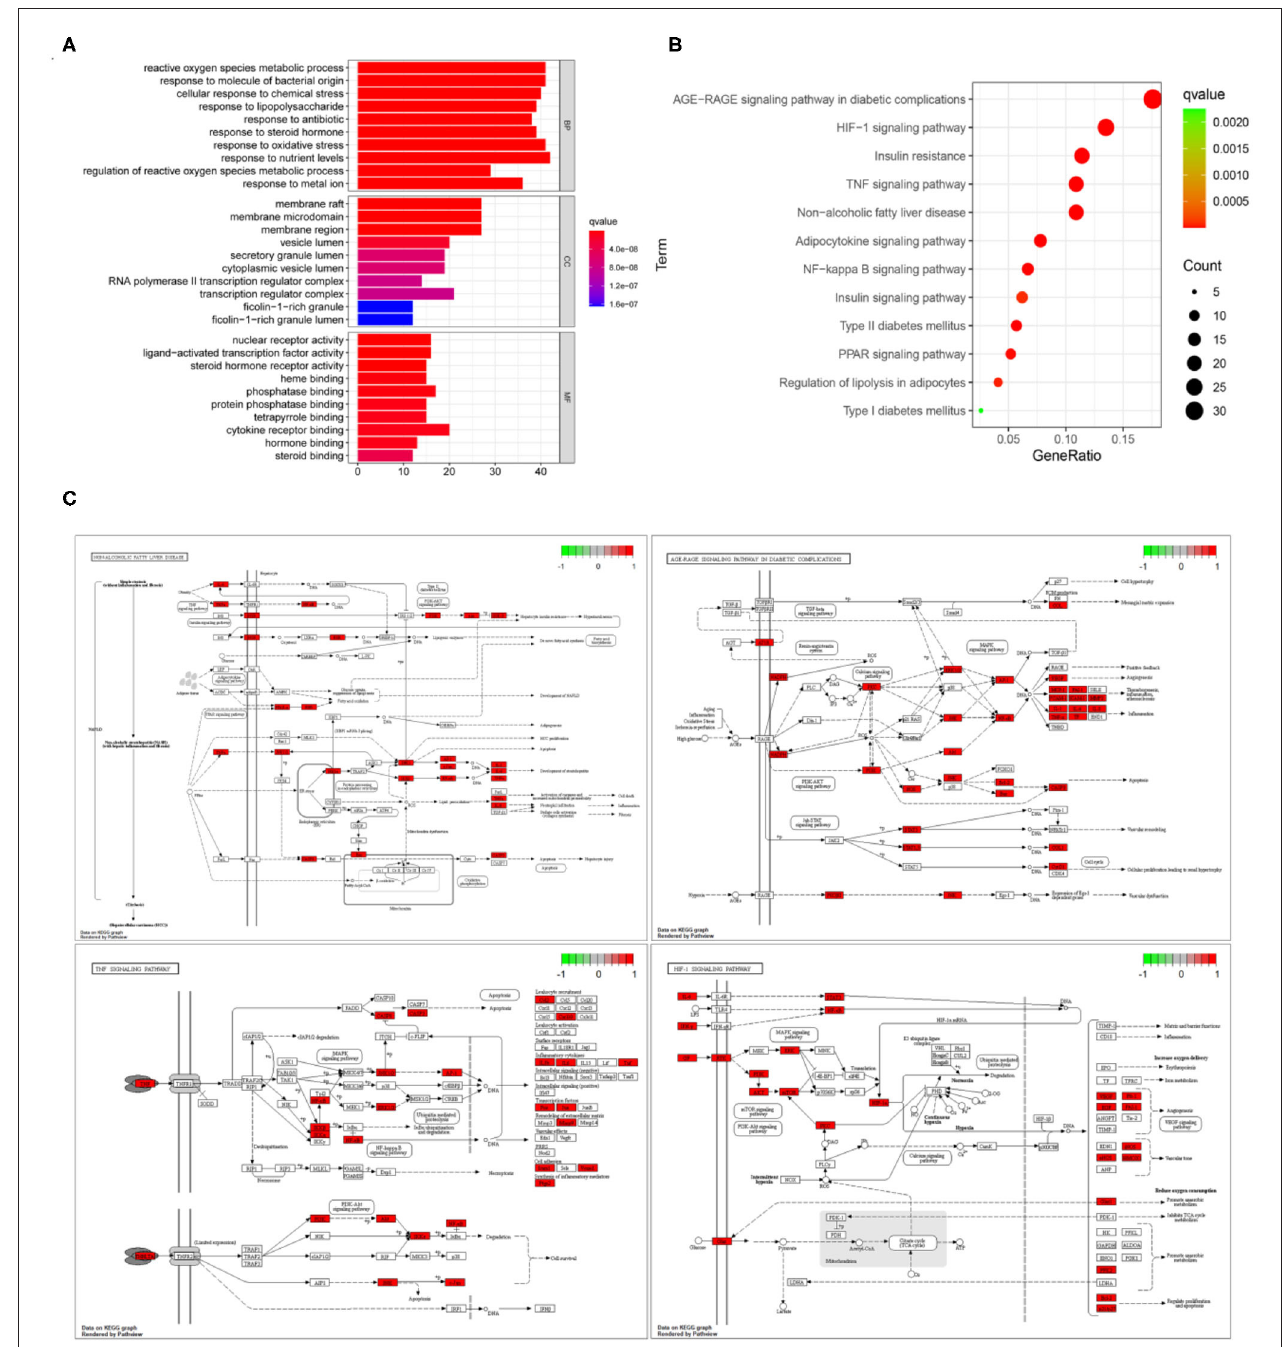
FIGURE 4 | GO and KEGG enrichment analysis. (A) GO enrichment analysis of the 206 common targets associated with NAFLD. The X -axis represents significant enrichment in the counts of these terms; The Y -axis showing the categories of biological process (BP), cellular component (CC), and molecular function (MF) in the GO of the target genes ( P < 0.05). (B) KEGG enrichment analysis. The X -axis showing the counts of the target symbols in each pathway; the Y -axis showing the main pathways ( P < 0.05). (C) The specific position and function of common targets in in signaling pathways. The red region represents the specific position of these common targets in the